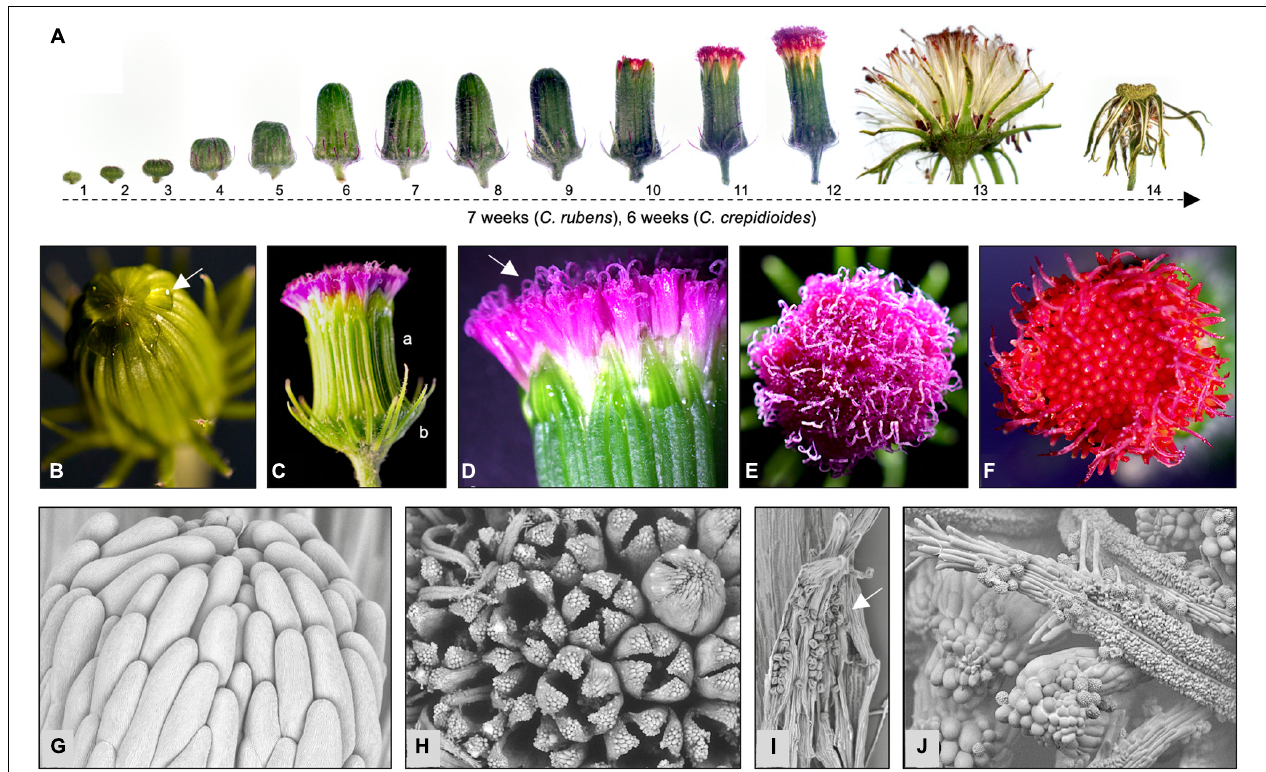
FIGURE 1 | Crassocephalum rubens and C. crepidioides form composite flowers, whose disk florets differ in corolla color. (A) Stages of flower development of C. crepidioides Ile-Ife. (B–E) Flower details of C. rubens Mali and C. crepidioides Ile-Ife (F) . Nectarous secretions on the tip of a capitulum prior to anthesis at stage 9 (B) . Side view of a capitulum after anthesis showing the outer (a) and inner (b) involucral bracts (C) . Side view of a capitulum with open florets and emerged stigmas (D) . Top view of a capitulum of C. rubens at stage 12 (E) . (F) Top view of a capitulum of C. crepidioides at stage 11. (G–I) Scanning electronic microscopic pictures of flower details of C. crepidioides Ile-Ife. Side view of a closed capitulum (G) . Top view of a capitulum with different floret stages being visible (H) . Open anthers containing pollen (I) . The stigma of C. crepidioides with pollen attached (J)